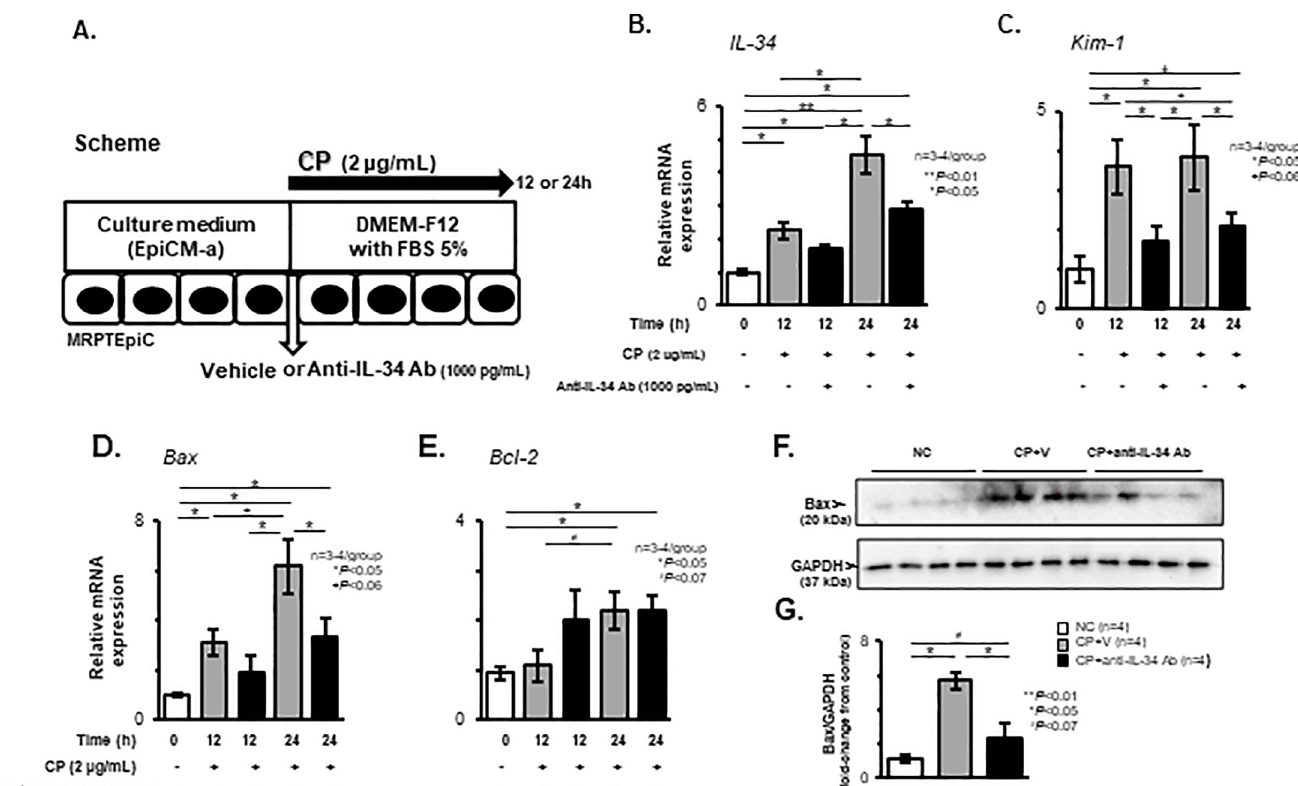
Fig 8. Cellular injury and apoptosis in CP-stimulated MRPTEpiC. Scheme for the in vitro analysis. Cultured MRPTEpiC were stimulated with or without CP (2 μ g/mL), followed by treatment with vehicle or anti-IL-34 Ab (1000 pg/mL) for 12 or 24 h ( A ). The IL-34 ( B ) and Kim-1 ( C ) mRNA expression levels in TECs, as assessed by real-time RT-PCR, among the study groups. Real-time RT-PCR for Bax ( D ) and Bcl-2 ( E ) in CP-stimulated MRPTEpiC with or without anti-IL-34 Ab treatment for 0 to 24 h. Values were normalized to the GAPDH transcript, and are expressed as the relative ratio. Representative WB analysis for Bax and GAPDH ( F ). Densitometric analysis of WB for Bax. The values shown are the values after normalization to GAPDH expression, and they are depicted as the relative ratio of Bax to GAPDH ( G ). Data are expressed as the mean ± SEM. The Mann-Whitney U test was used for statistical analysis.